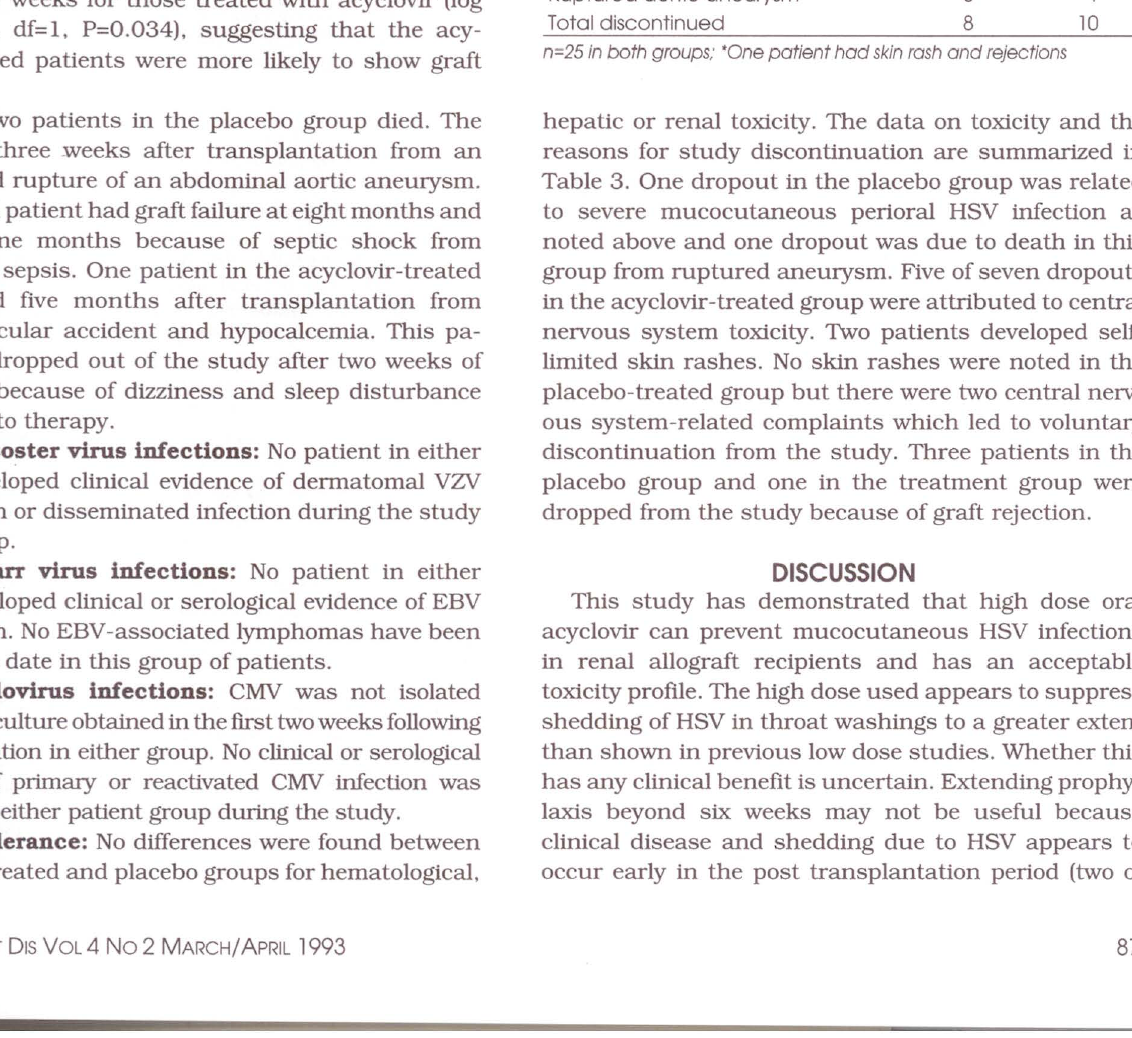
Figure 1) Survival of renal allografts in patients treated with acyclovir or placebo. Mean survival time was greater for acy clovir-treated patients (P=0.34)